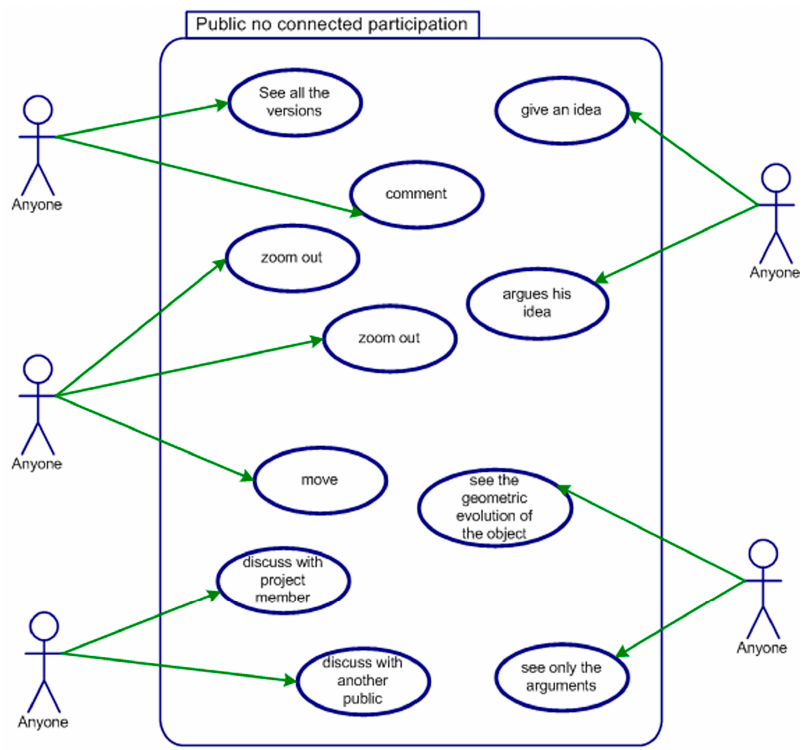
Figure 14. The behavior of authorized members with the system.